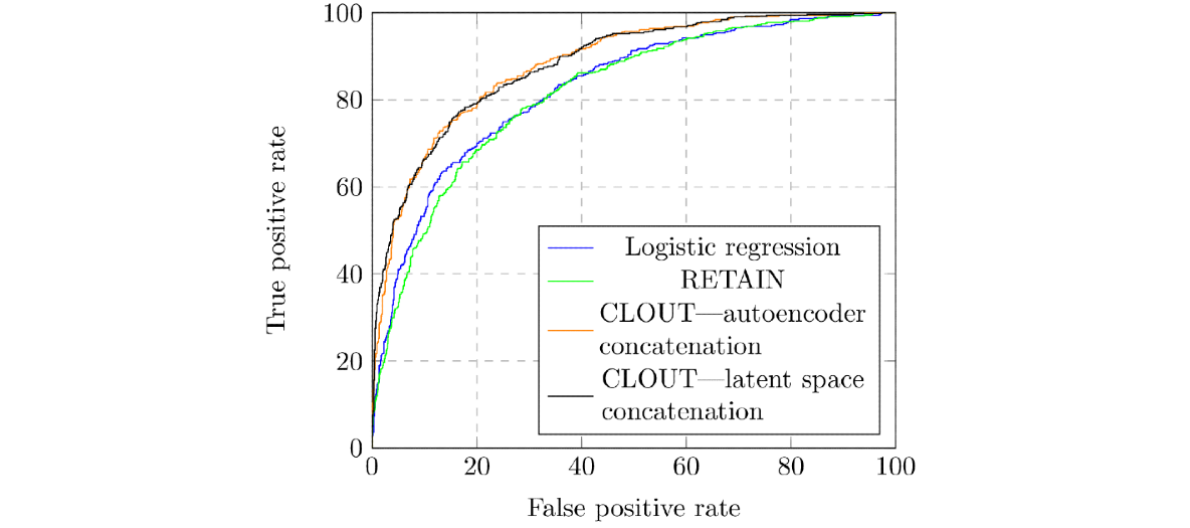
Figure 4. The area under the receiver operating characteristic curves for various models. RETAIN: Reverse Time Attention model; CLOUT: L(STM) Outcome prediction using Comprehensive feature